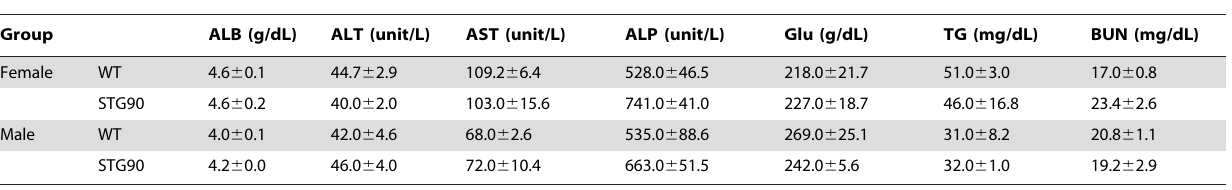
Table 1. Blood chemistry analysis (mean 6 standard error).